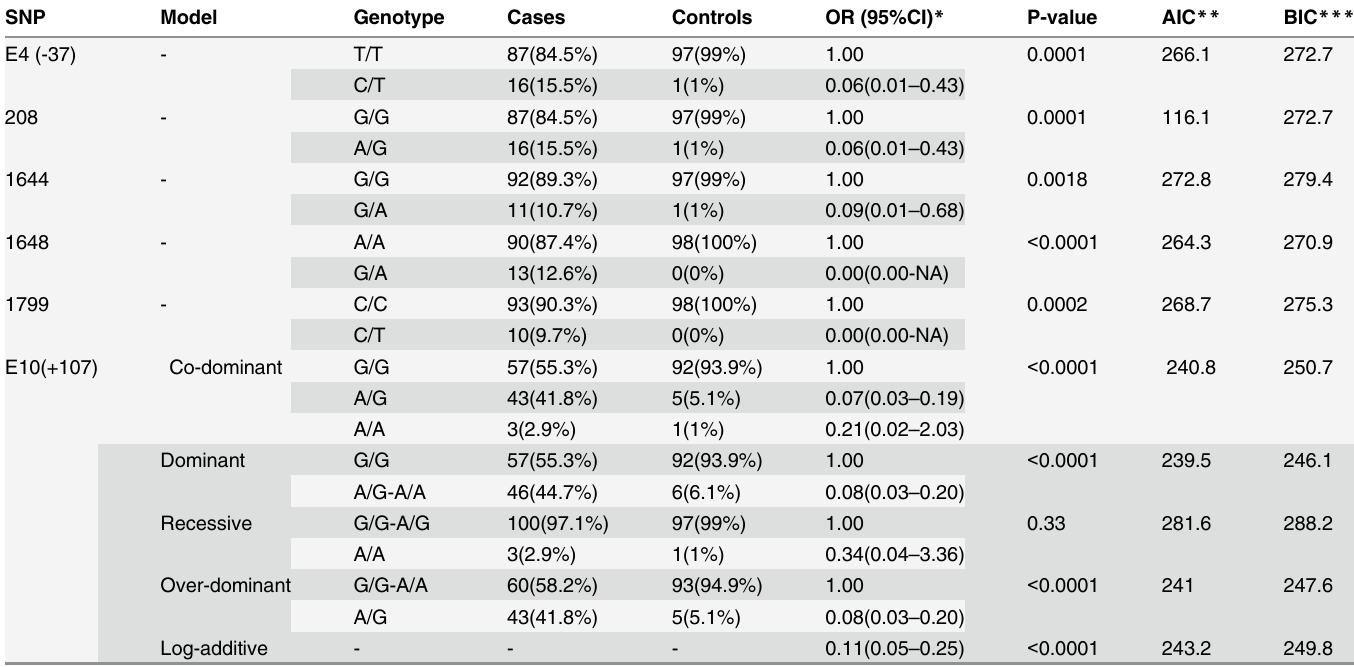
Table 4. Associations between E4 (-37), 208, 1644, 1648, 1799, E10 (+107), and bovine tuberculosis in Chinese Holstein cows. SNP Model